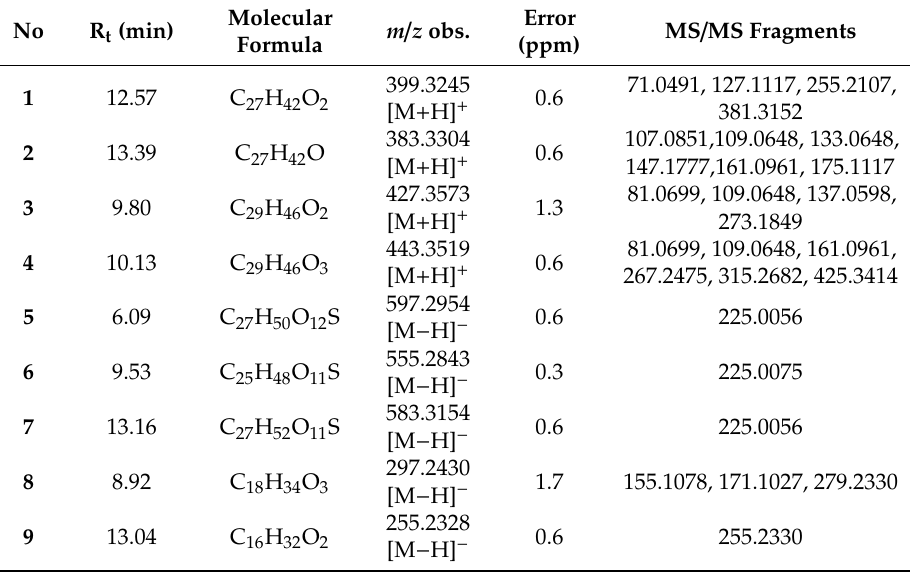
Figure 3. Total ion chromatogram and key peak identification of the M2 fraction of Turbinaria ornata extract (TOE) in positive mode ( A ) and negative mode ( B ). Table 1. Identification of compounds in M2 fraction of Turbinaria ornata extract (TOE) using LC-QTOF-MS analysis.